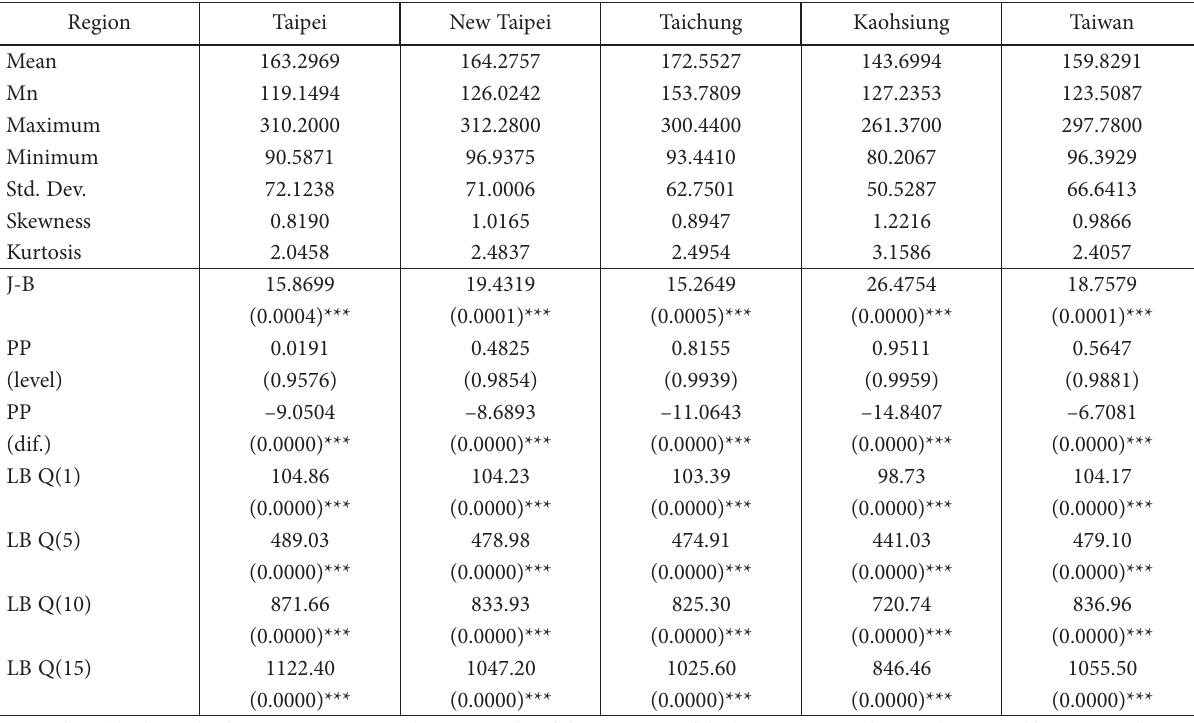
Table 1. Descriptive statistics and tests of housing price indices